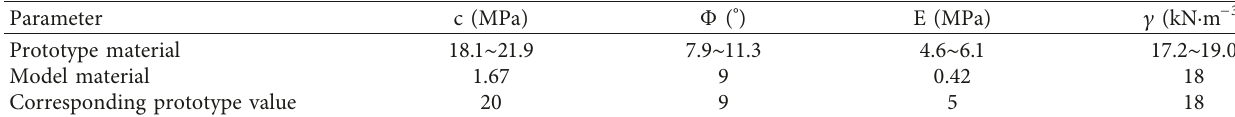
Table 3: Physical and mechanical parameters of soil.